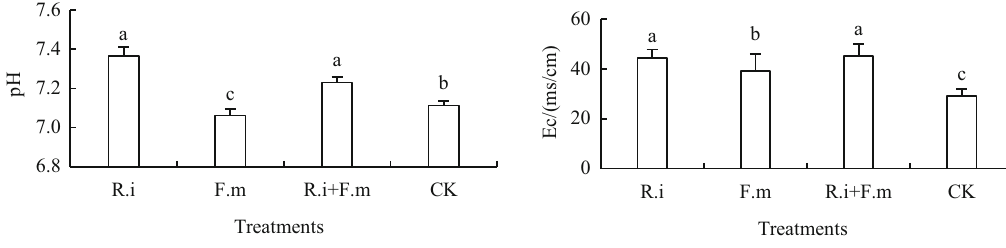
Fig. 4 Effect of AM inoculation on soil pH and Ec of Amygdalus pedunculata